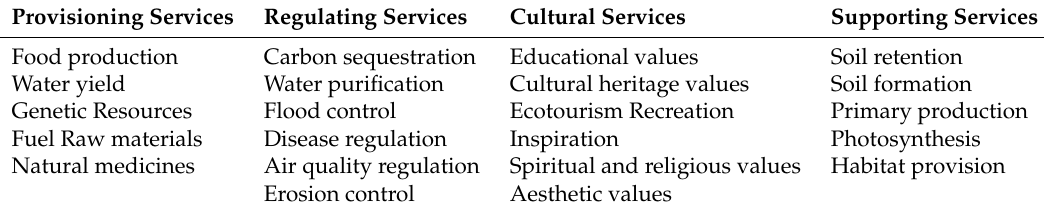
Figure 3. Number of studies reported under each anthropogenic-modification type after inclusion criteria were applied. Table 2. List of ecosystem services compiled from